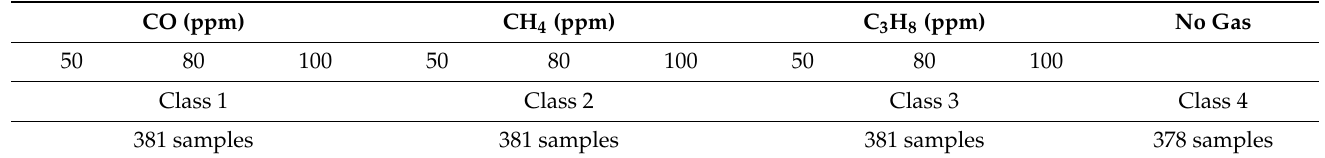
Table 1. Data labeling and curation for classification analysis.